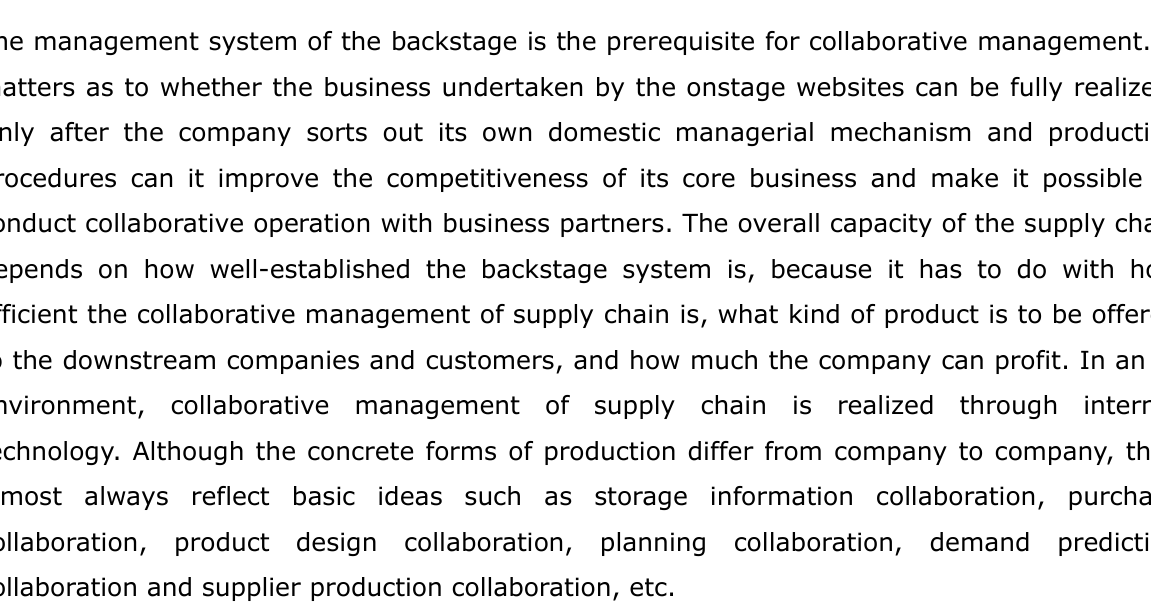
Figure 2. A sketch of the implications of collaborative management of supply chain in an IT environment